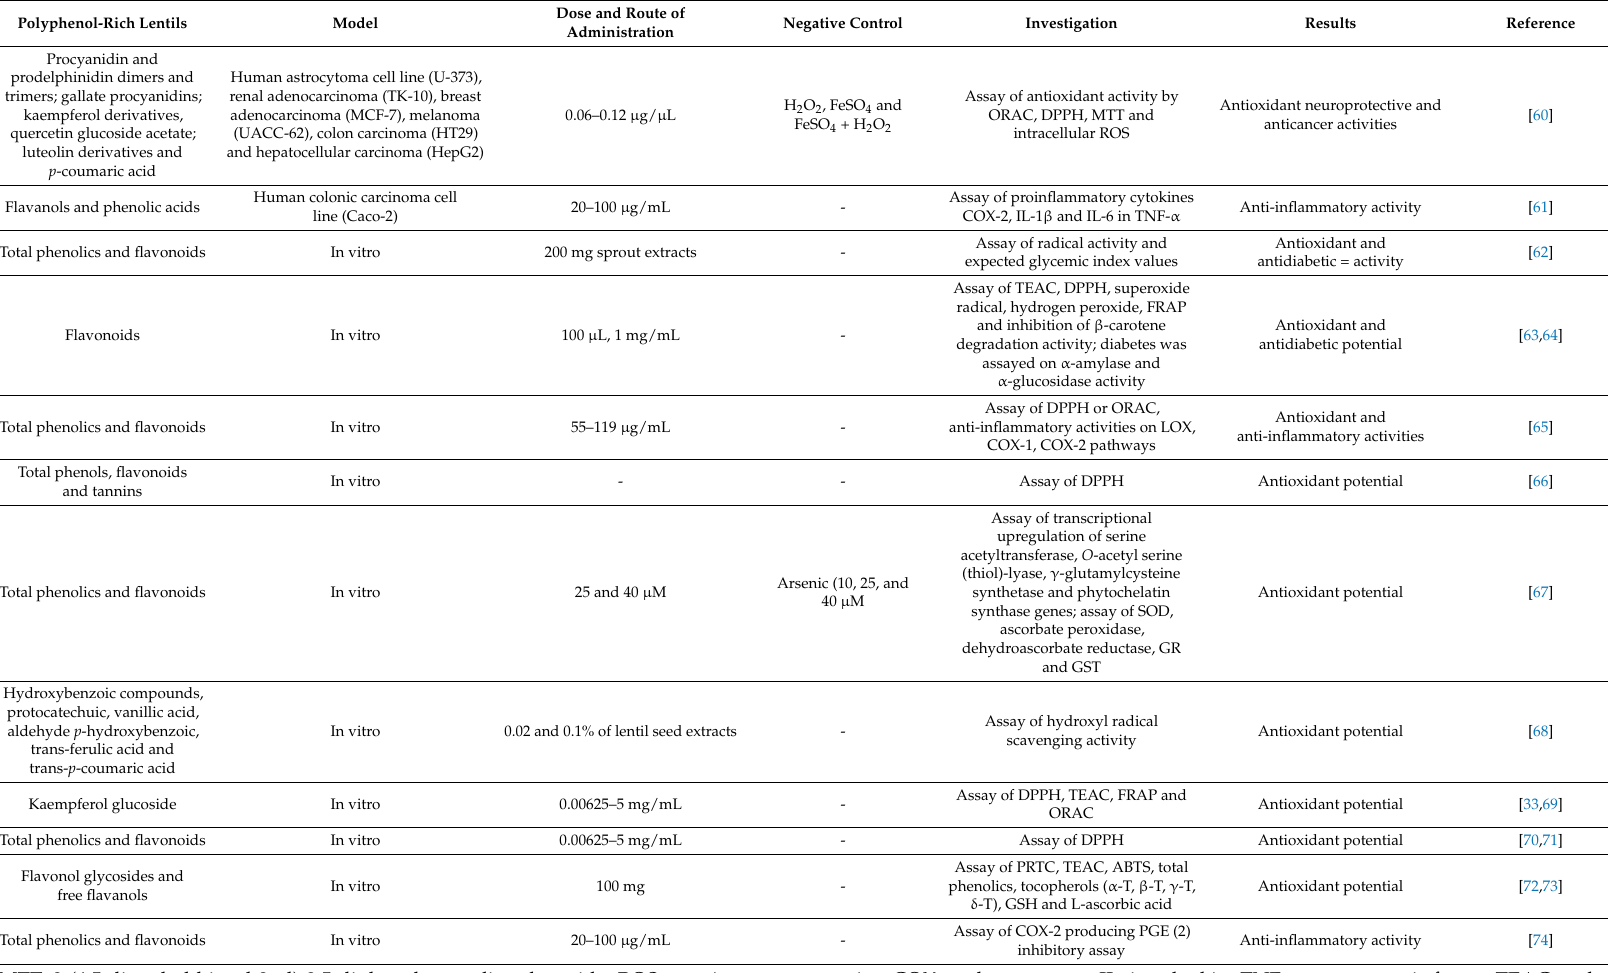
Table 5. Summary of in vitro, in vivo and clinical studies on the antioxidant activities of polyphenol-rich